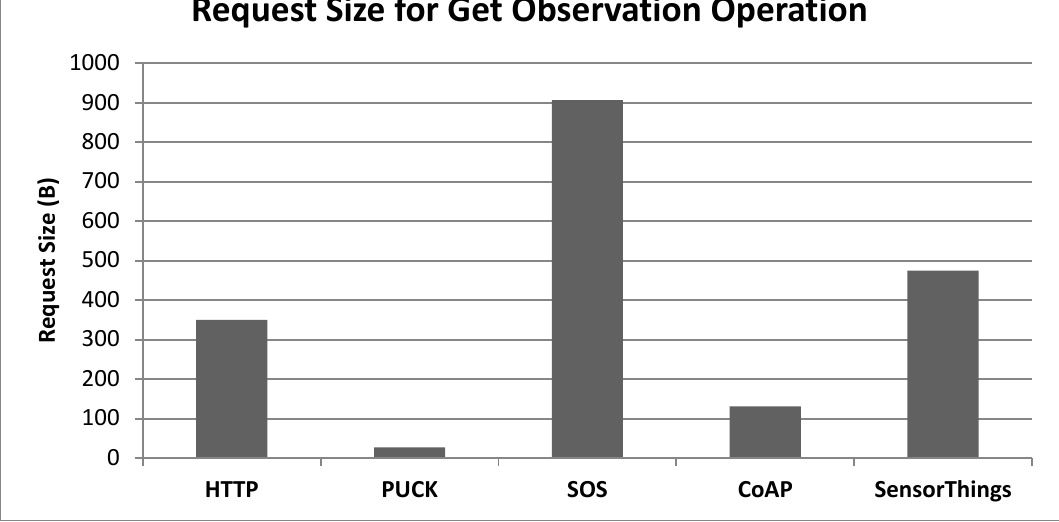
Figure 11. Request size evaluation for the get observation